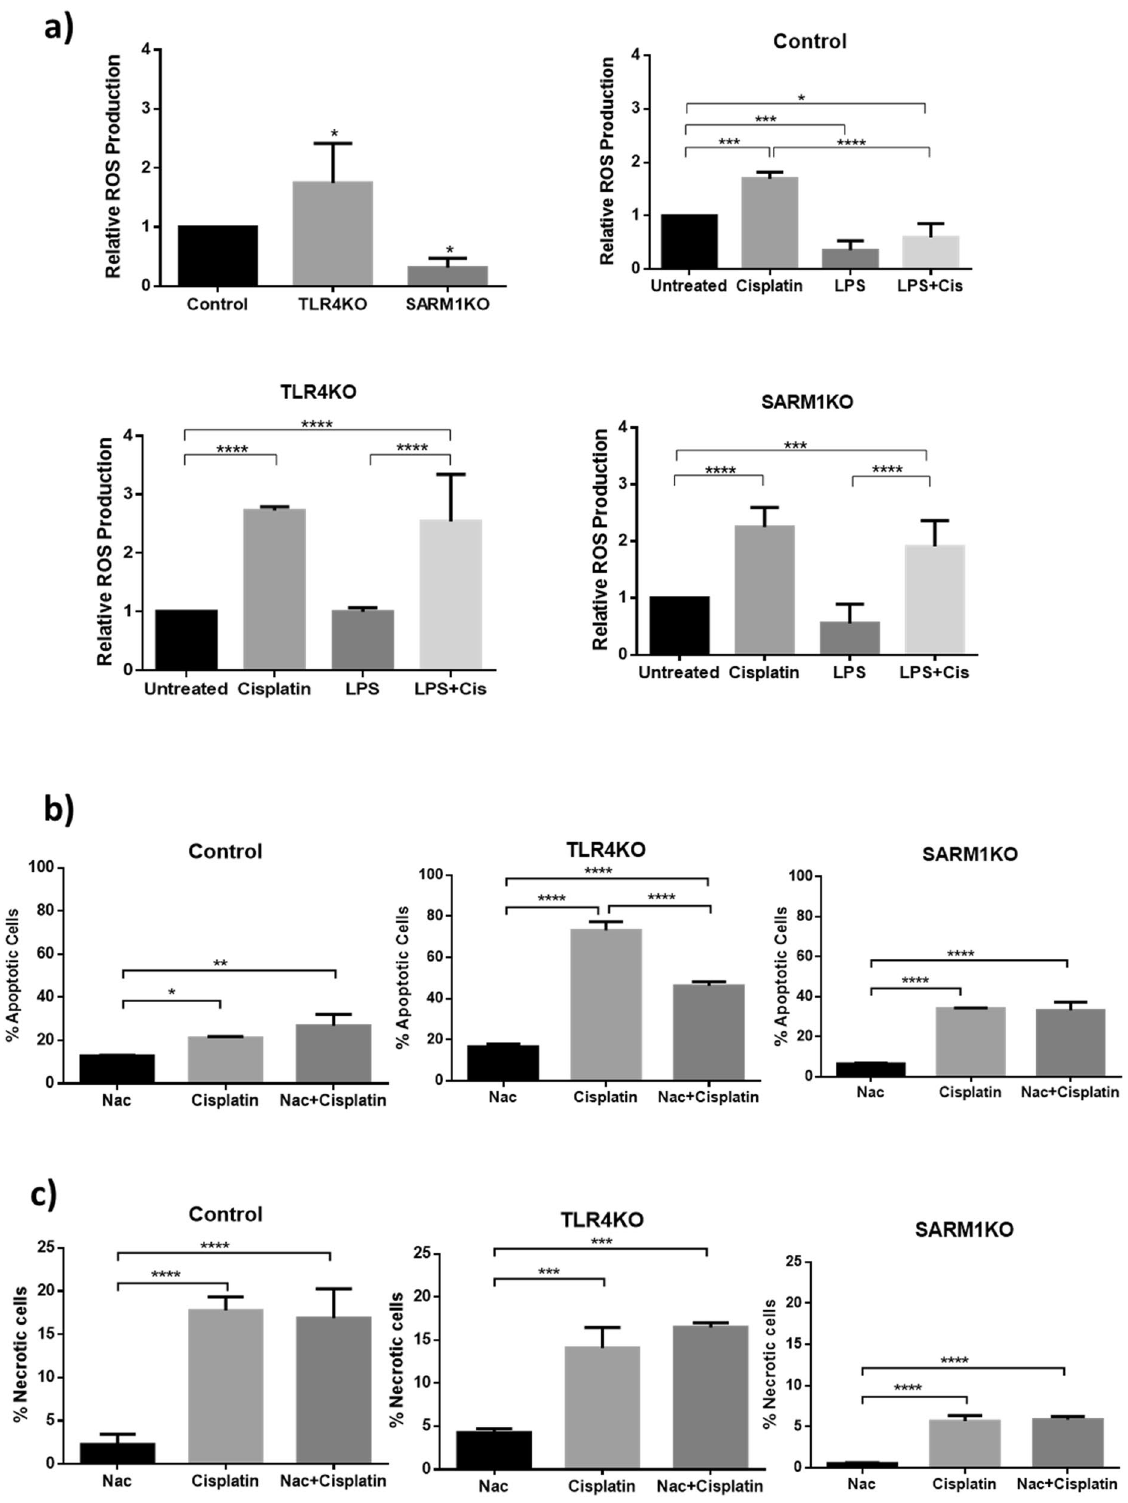
Figure 5. N acetyl L cysteine (NAC) reduces apoptosis in TLR4KO cells after cisplatin treatment. ( a ) ROS levels after cisplatin and LPS treatment in TLR4KO, SARM1KO and parental cells measured by flow cytometry. ( b ) Percentage of apoptotic cells determined by Annexin staining and flow cytometry analysis after 4.7 µM of cisplatin and 100 µM of NAC treatment for 72 h in parental, TLR4KO and SARM1KO cells. ( c ) Percentage of necrotic cells determined by 7-AAD and flow cytometry analysis after 4.7 µM of cisplatin and 100 µM NAC treatment for 72 h in TLR4KO, SARM1KO and parental cells. Data displayed as mean ± SD. (* p ≤ 0.05; ** p ≤ 0.01; *** p ≤ 0.001; **** p ≤